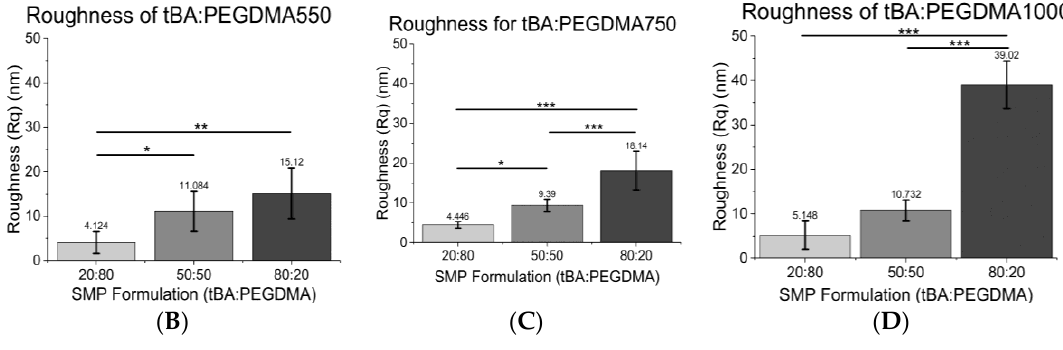
Figure 4. ( A ) Representative Atomic Force Microscopy (AFM) images of tBA:PEGDMA550 samples.